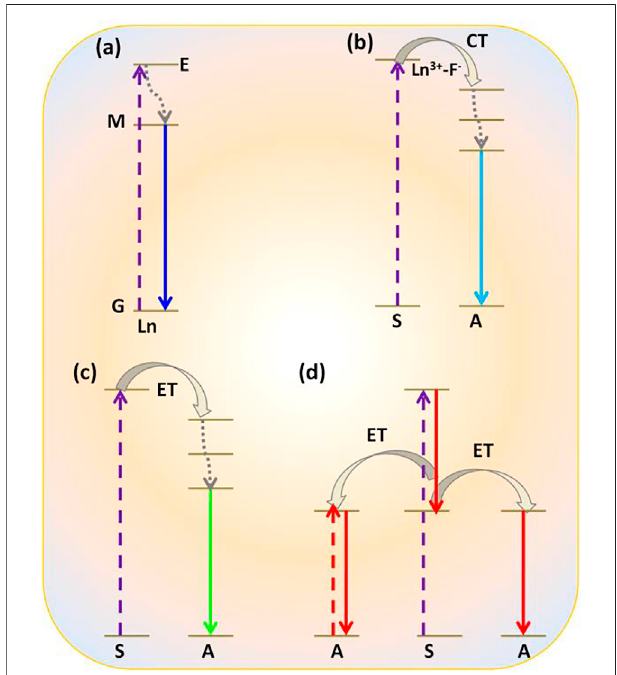
FIGURE 1 | Photophysical processes shown by RE 3+ -doped nanomaterials: (A) downshifting; (B) charge transfer (CT); (C) energy transfer (ET); (D) quantum cutting